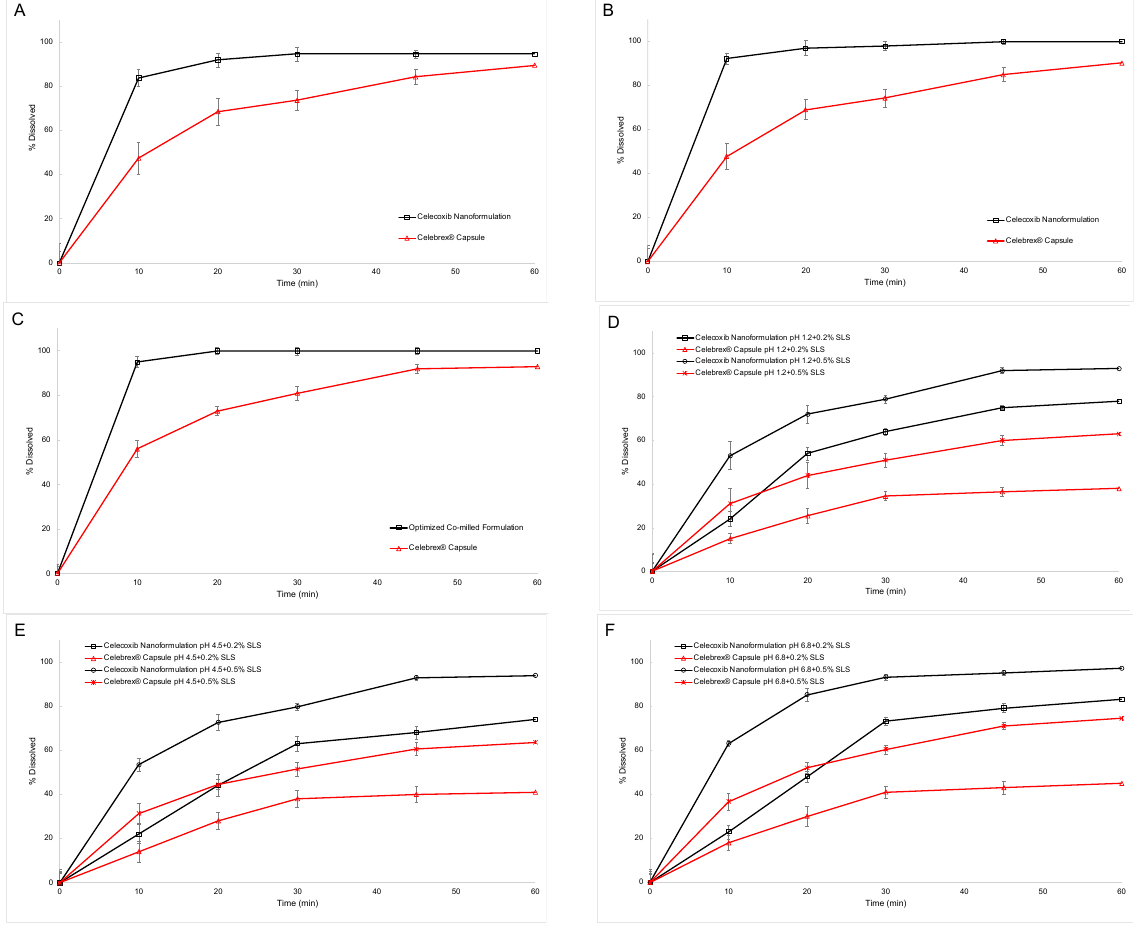
Figure 9. In vitro dissolution profiles of celecoxib nanoformulation and Celebrex ® capsule in different dissolution media (sink condition: A : pH 1.2 + 0.2%, B : pH 4.5 + 0.2%, C : pH 6.8 + 0.2%; non-sink condition: D : pH 1.2 + 0.2% and 0.5%, E : pH 4.5 + 0.2% and 0.5%, F : pH 6.8 + 0.2% and 0.5%).